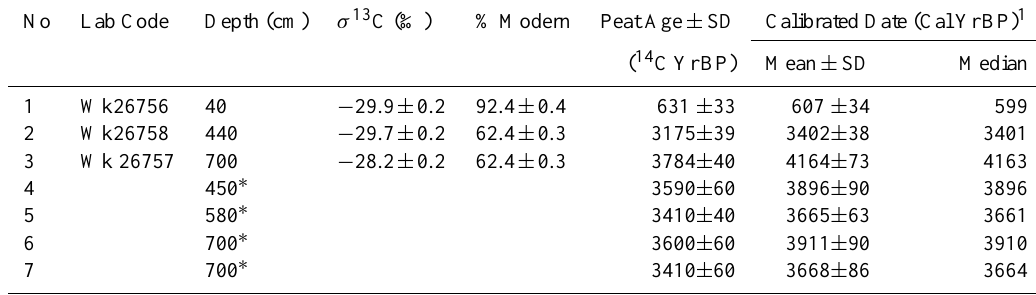
Table 2. 14 C and Calibrated Calendar Ages of coastal peats from the lower Kapuas River basin. No Lab Code Depth (cm) σ 13 C (‰) % Modern Peat Age ±